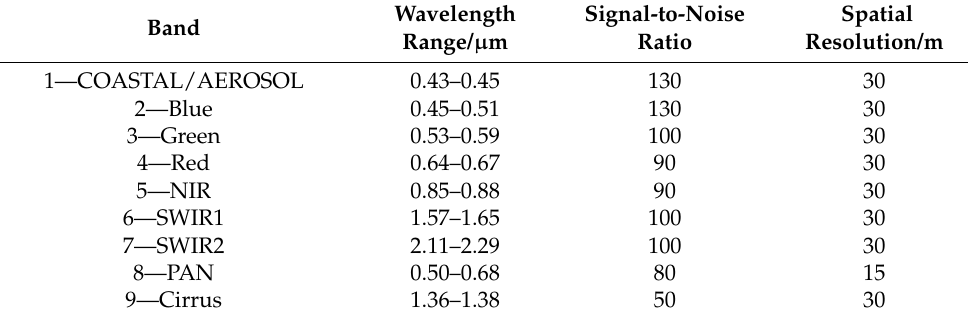
Table 2. Landsat8 OLI image band parameters.